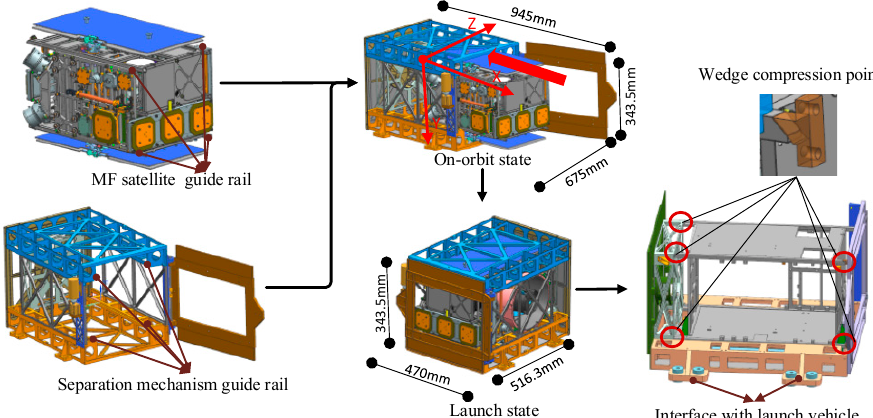
Figure 4. Mechanical interface diagram for the separation mechanism and the MF satellite.